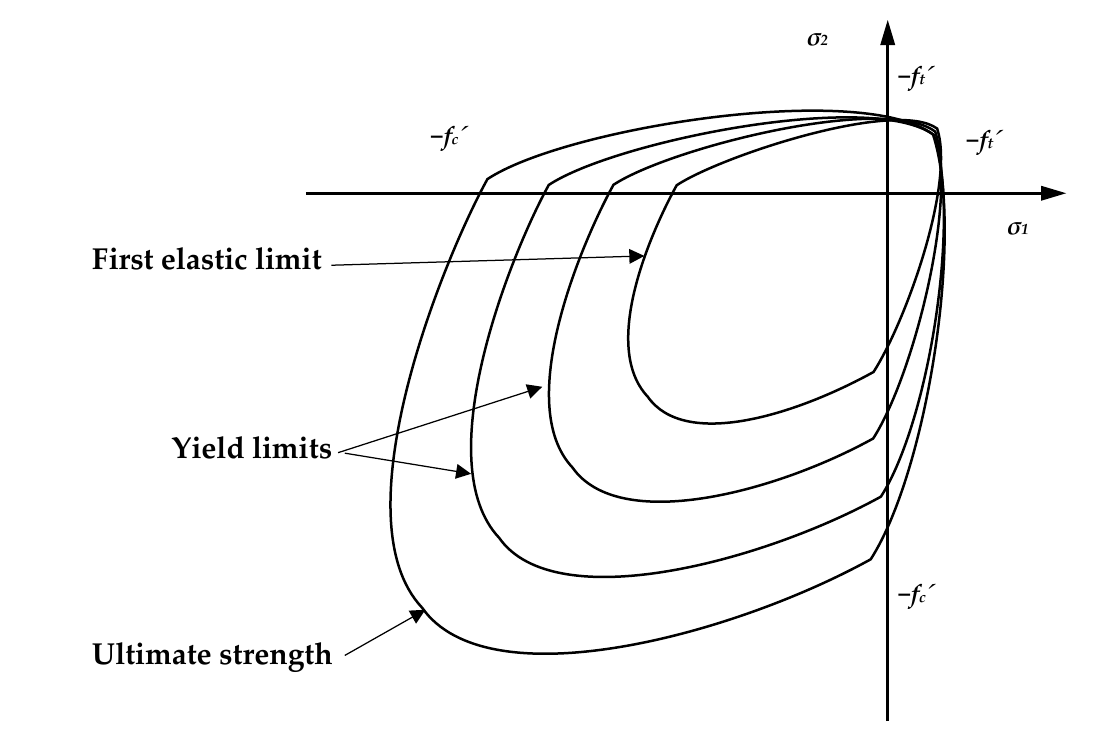
Figure 16. Composite material model principle “Cast − Iron”.